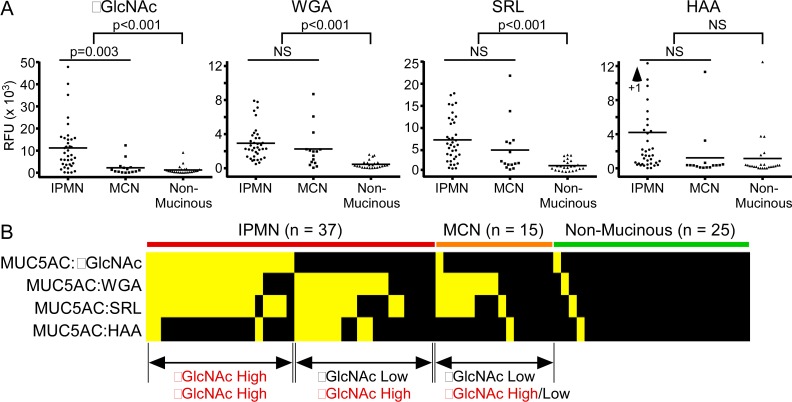
Elevation of the αGlcNAc and βGlcNAc glycoforms of MUC5AC in mucinous cysts.A) The αGlcNAc glycoform of MUC5AC was higher in mucinous relative to non-mucinous cysts, and in IPMNs relative to MCNs. The WGA-reactive and SRL-reactive glycoforms were higher in mucinous cysts but not in IPMNs relative to MCNs. The HAA-reactive glycoform was on average higher in IPMNs but not statistically significantly (by t-test) due to high variability between individual levels. B) About half of the IPMNs were elevated in αGlcNAc, and most of the remaining IPMNs were elevated in βGlcNAc. The MCNs are not elevated in αGlcNAc, and about half are elevated in βGlcNAc.